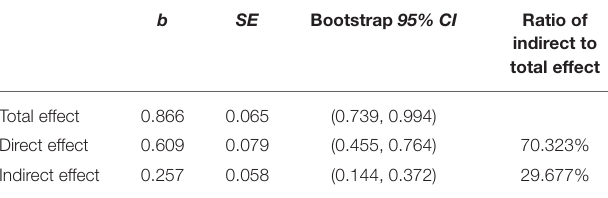
TABLE 4 | Mediating